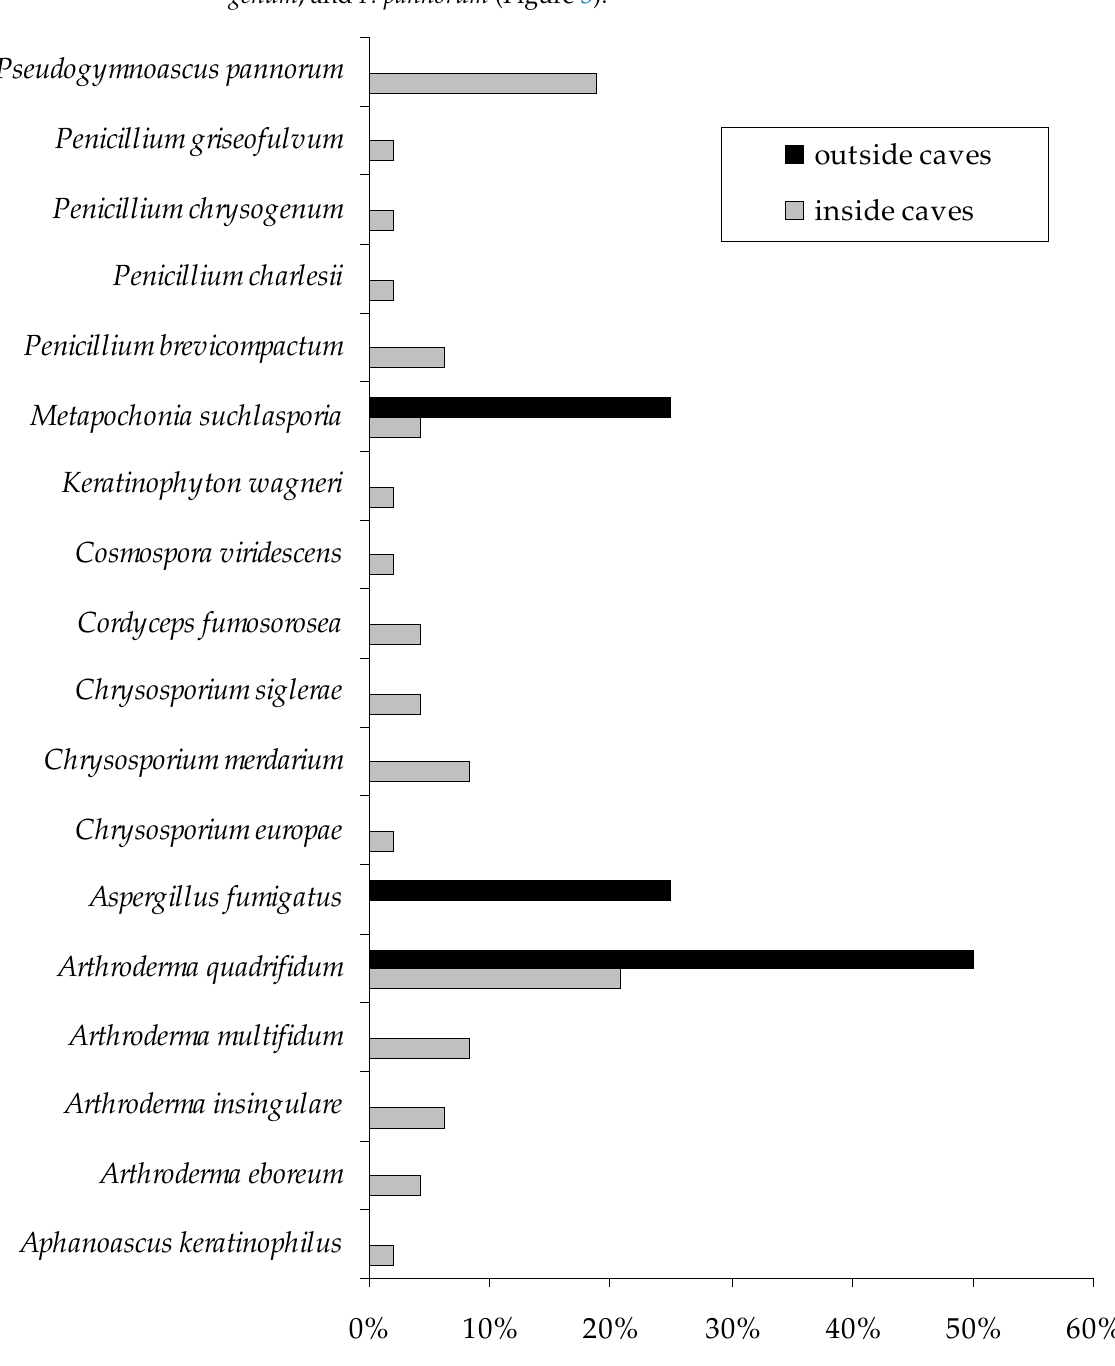
Figure 2. The percentage contribution of each isolate from the soil/sediment samples to the total from all caves.